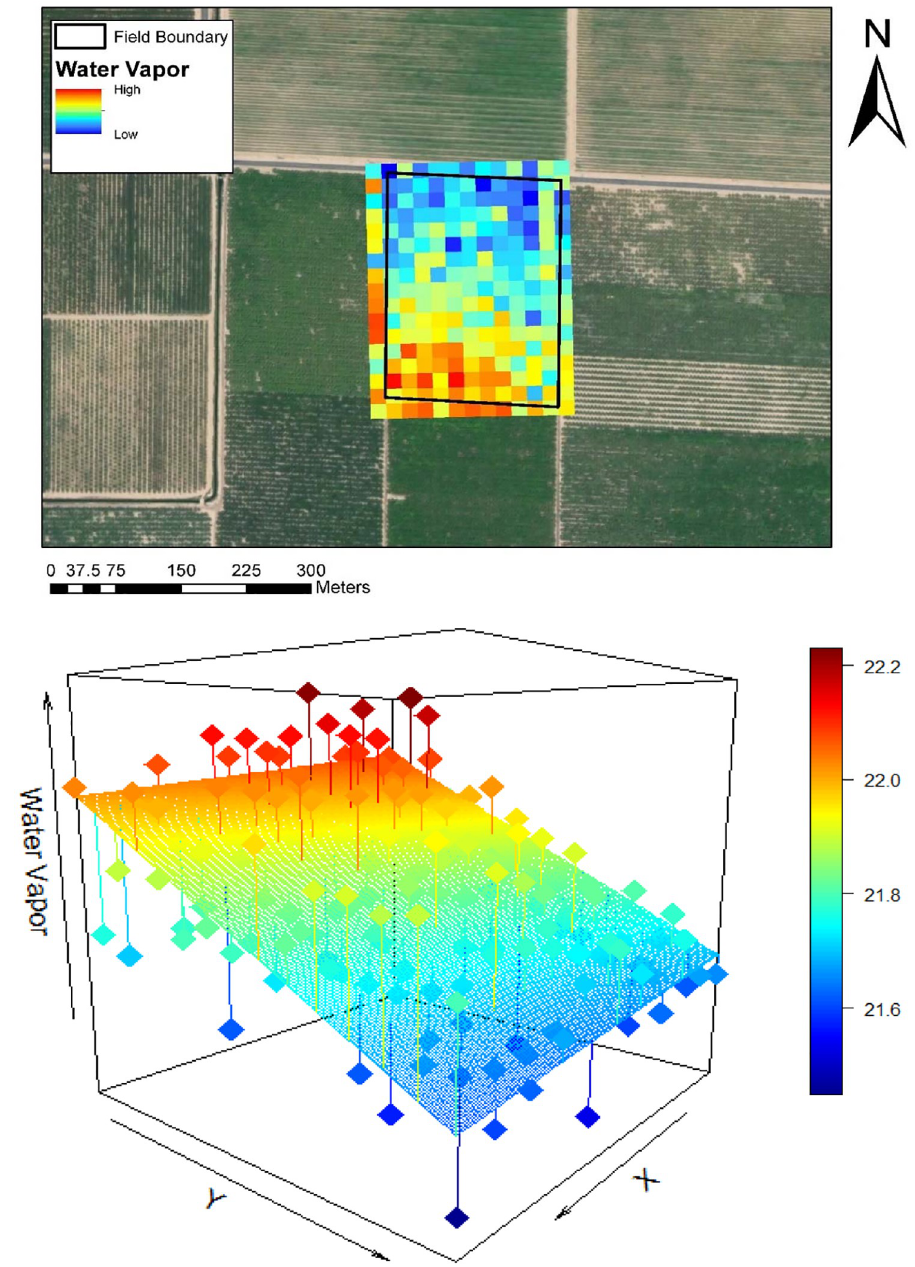
Fig 4. Water vapor trend occurring over an example field. The top graphic shows pixel-level water vapor measurements from 2013 from AVIRIS above polygon “152351”, a field of nectarines. The bottom plot illustrates the same water vapor measurements, fitted by a linear trend surface. Column water vapor values reported in millimeters. Slope = 0.99 and r 2 = 0.61. Basemap obtained from Esri ArcGIS. Sources: Esri, DigitalGlobe, GeoEye, i-cubed, USDA FSA, USGS, AEX, Getmapping, Aerogrid, IGN, IGP, swisstopo, and the GIS User